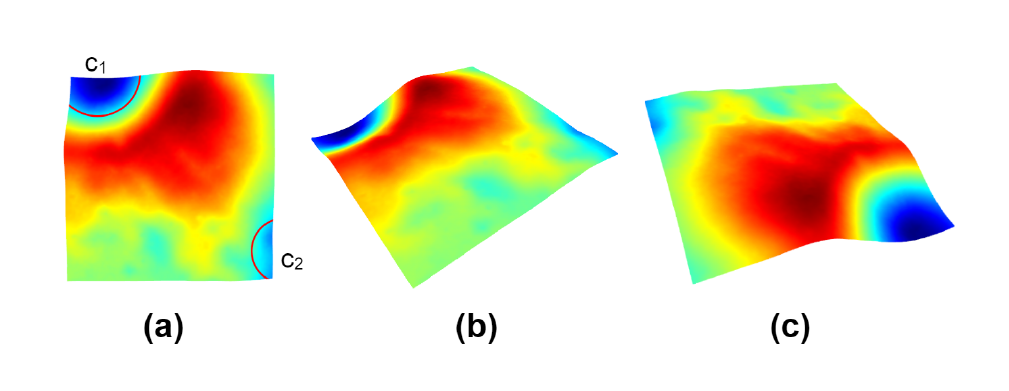
Figure 7. Heat map of point cloud dataset of the moon. In ( a ), there are impact craters C 1 and C 2 in the upper left corner and the lower right corner, respectively. From other perspectives, ( b , c ) show that the boundary of C 2 is not as obvious as C 1